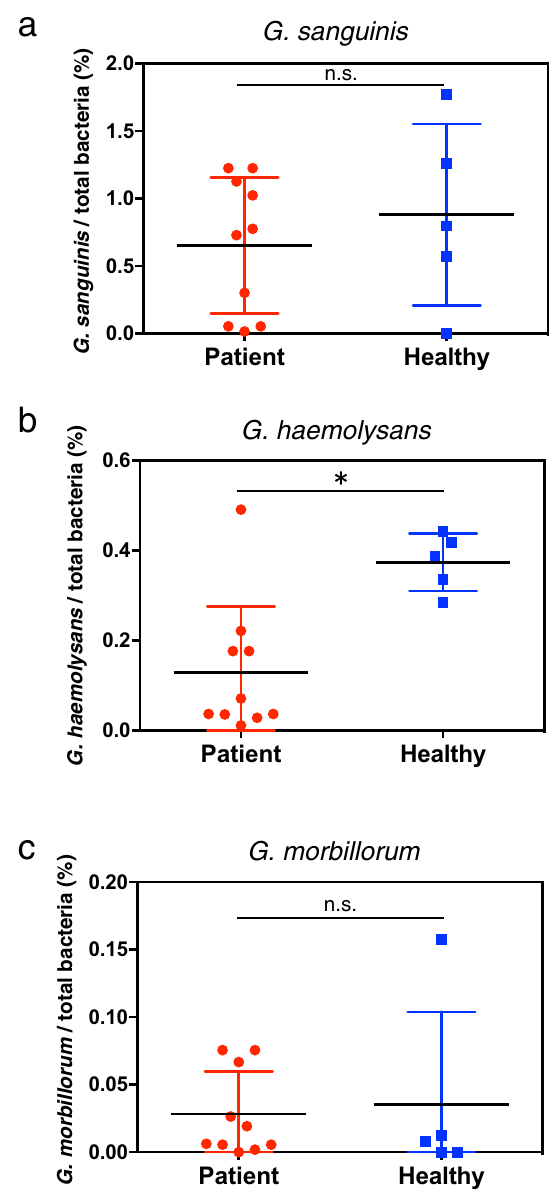
Figure 2. Levels of G. haemolysans in the saliva of healthy subjects and periodontitis patients. (a–c) Quantification of Gemella species in the saliva of healthy subjects and periodontal disease patients. The percentages of G. sanguinis (a) , G. haemolysans (b) , and G. morbillorum (c) among the total salivary bacteria were determined by quantitative PCR analysis using specific primers for the 16S rRNA gene. The results for samples from the periodontal disease patients and healthy subjects are shown as red circles and blue squares, respectively. All data were analyzed using a two-tailed Mann–Whitney U-test. ns, not significant. *P < 0.05. Error bars show the mean ±